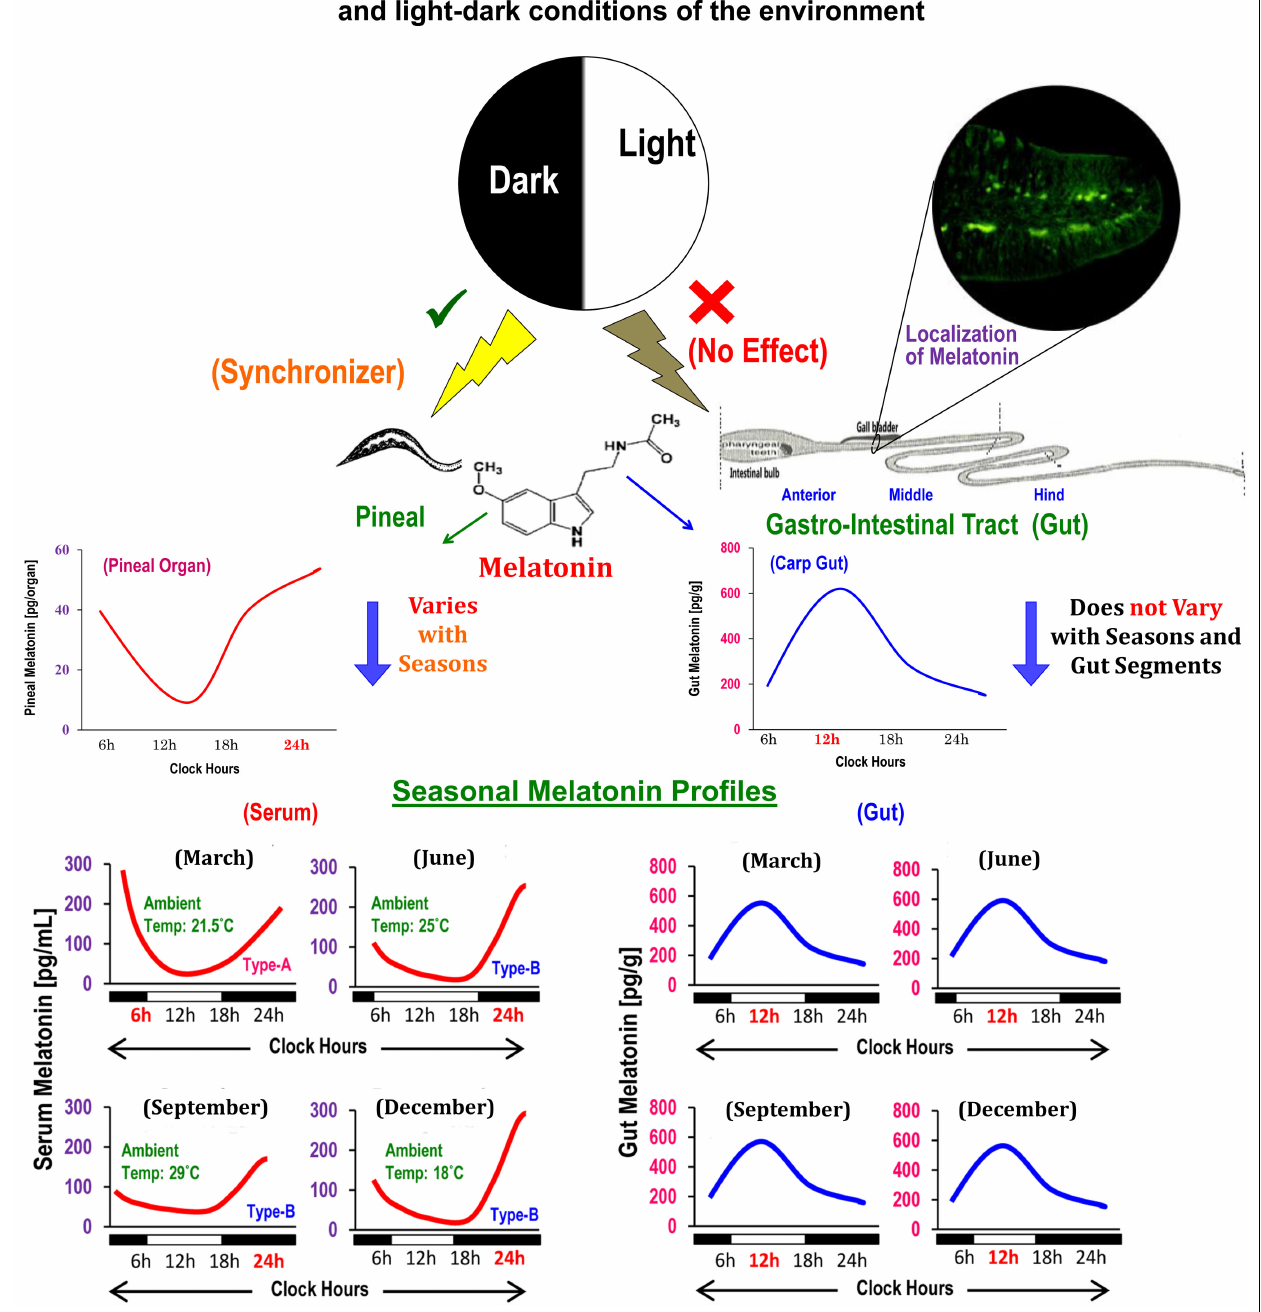
FIGURE 1 | Schematic presentation of the summary of existing information on the localization, distribution, and temporal organization of melatonin concentrations in different anatomical segments of gut in relation to the diurnal and seasonal profiles of serum melatonin in carp Catla catla and light–dark cycle in the environment